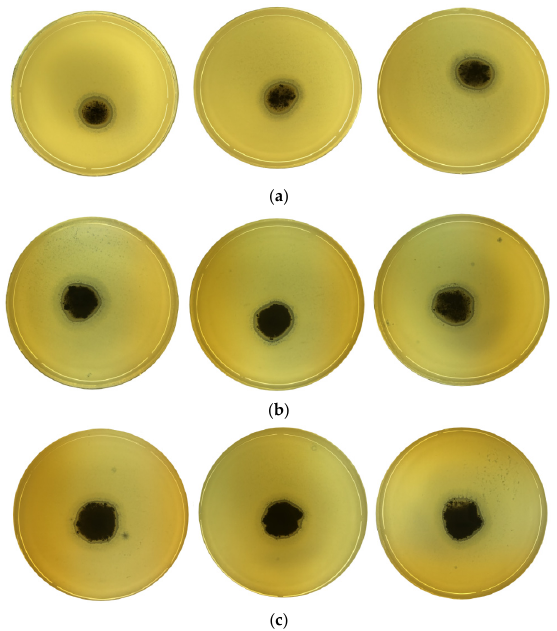
Figure 10. Inhibition zone revealing the antibacterial activity at 37 ◦ C of different BN-Ag 0 catalyst doses: 10 mg ( a ), 20 mg ( b ) and 30 mg ( c ), (in triplicate) for ISO SS